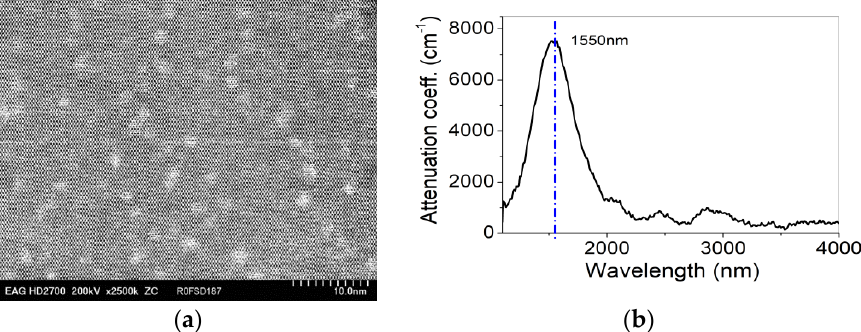
Figure 1. ( a ) A TEM image of ErAs quantum dots. The image was taken by an EAG Laboratory in Raleigh, NC, USA. ( b ) Attenuation spectrum of GaAs: ErAs sample. Raleigh, NC, USA. ( b ) Attenuation spectrum of GaAs: ErAs sample.